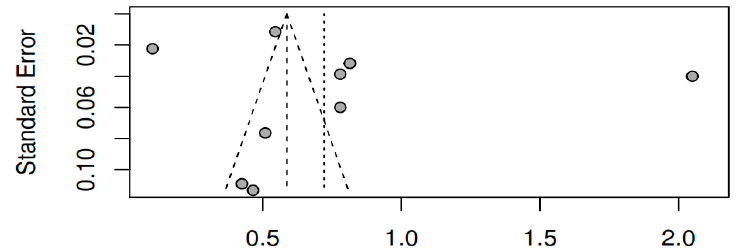
Figure 9. Funnel plot of the overall symptomatology variable (pretest–posttest).